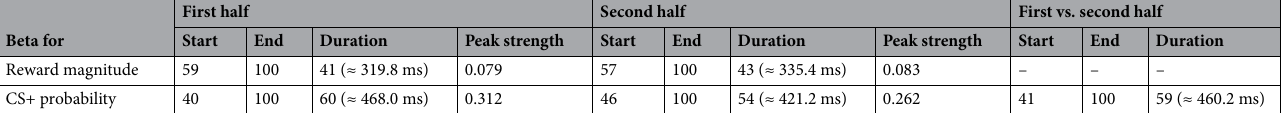
Table 3. Segments of significant beta weights for Reward Magnitude and CS+ Probability separately for the first and the second half of the approach-avoidance paradigm in the aversive learning group. In the aversive learning group, a time slice corresponds on average to 7.8 ms. Only segments of more than 10 significant t -tests were accepted as